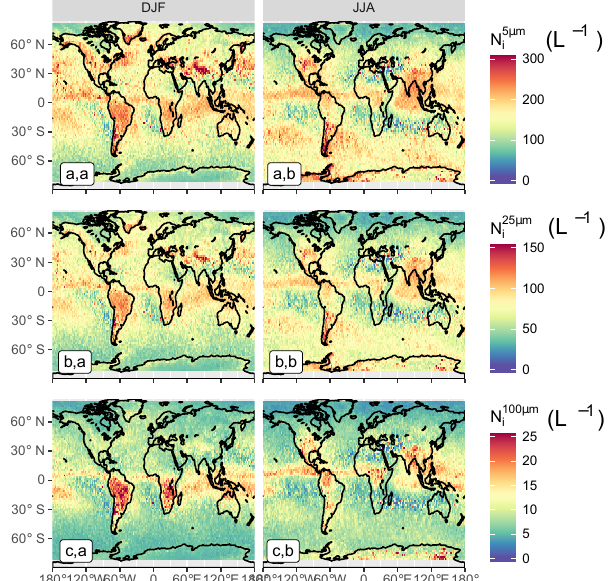
Figure 8. Spatial distribution in N 5µm ( a.a; a.b ), N 25µm ( b.a; b.b ) i i and N 100µm ( c.a; c.b ) between − 60 and − 50 ◦ C , during Northern i Hemisphere winter (DJF; a.a; b.a; c.a ) and summer (JJA; a.b; b.b; c.b )